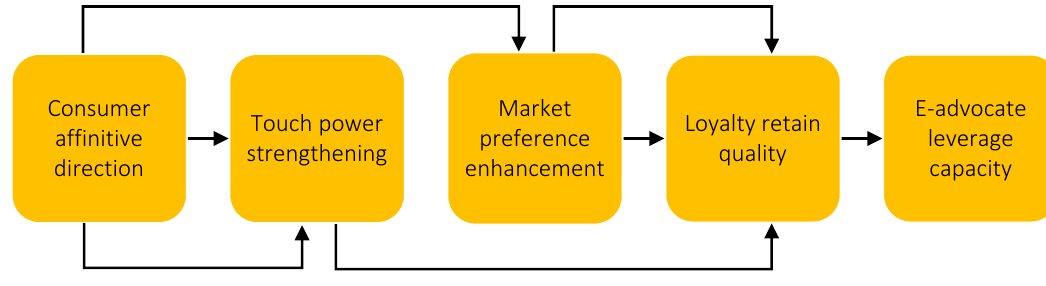
Figure 2. Corporate marketing